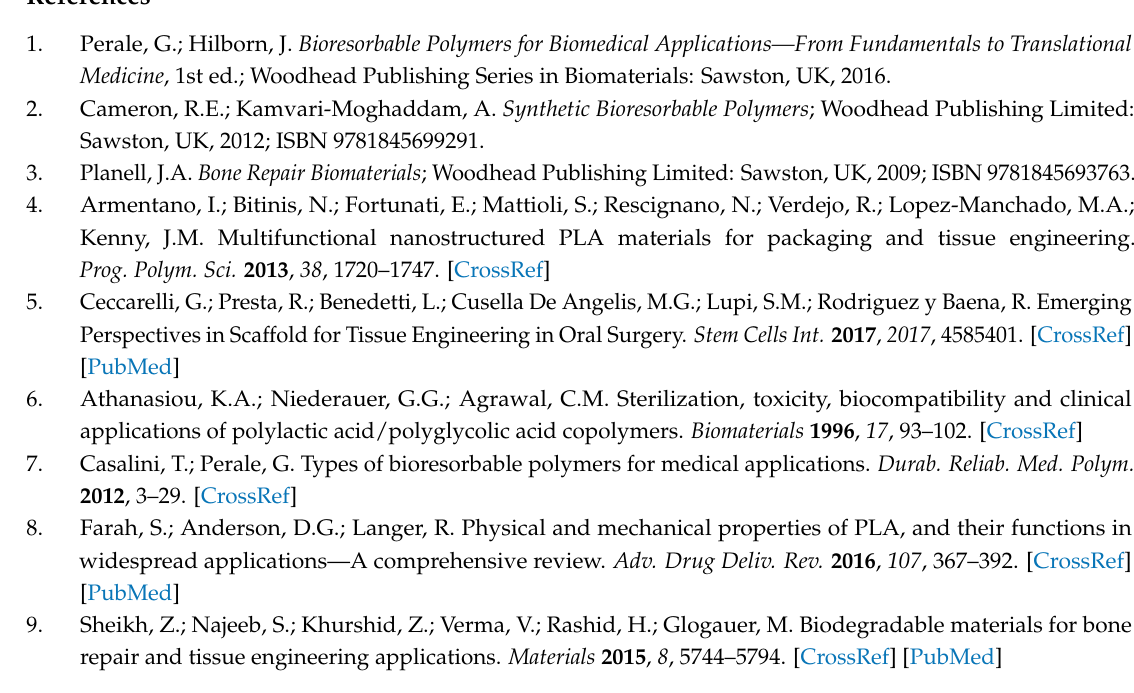
Figure S1: NMR spectra of P and E samples, Figure S2: XRD spectra of P (blue line) and E (red line), Figure S3: NMR spectra of P and E after EtO, Figure S4: XRD spectra of P (blue line) and E (red line) after EtO, Figure S5: NMR spectra of P and E after electron beam irradiation, Figure S6: XRD spectra of P and E after electron beam